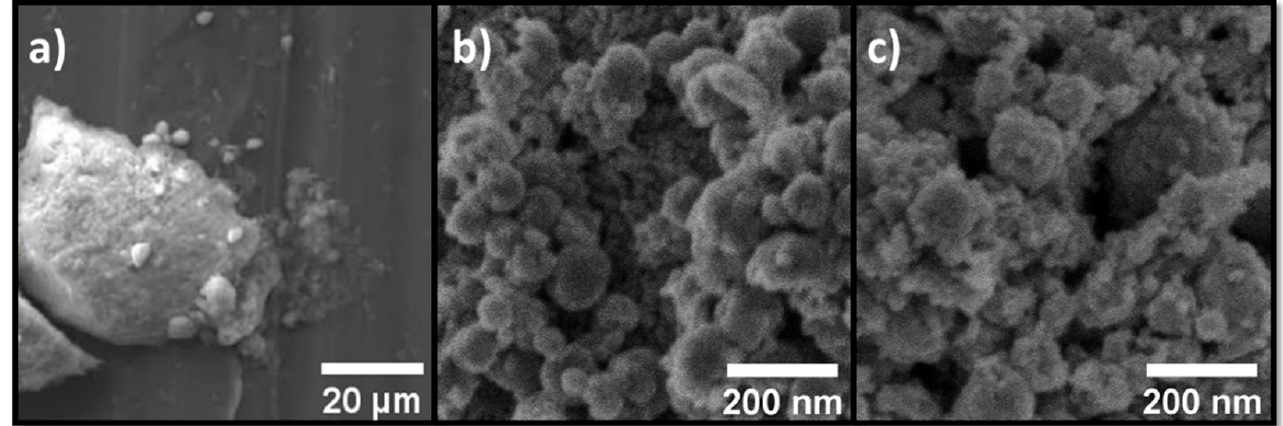
Figure 2. Scanning electron microscopy (SEM) micrographs of ( a , b ) pristine α -Fe 2 O 3 nanoparticles and ( c ) α -Fe 2 O 3 /Ag nano-composite. Pristine hematite was obtained ( a ) in the absence and ( b ) presence of polyethylene glycol as surfactant.